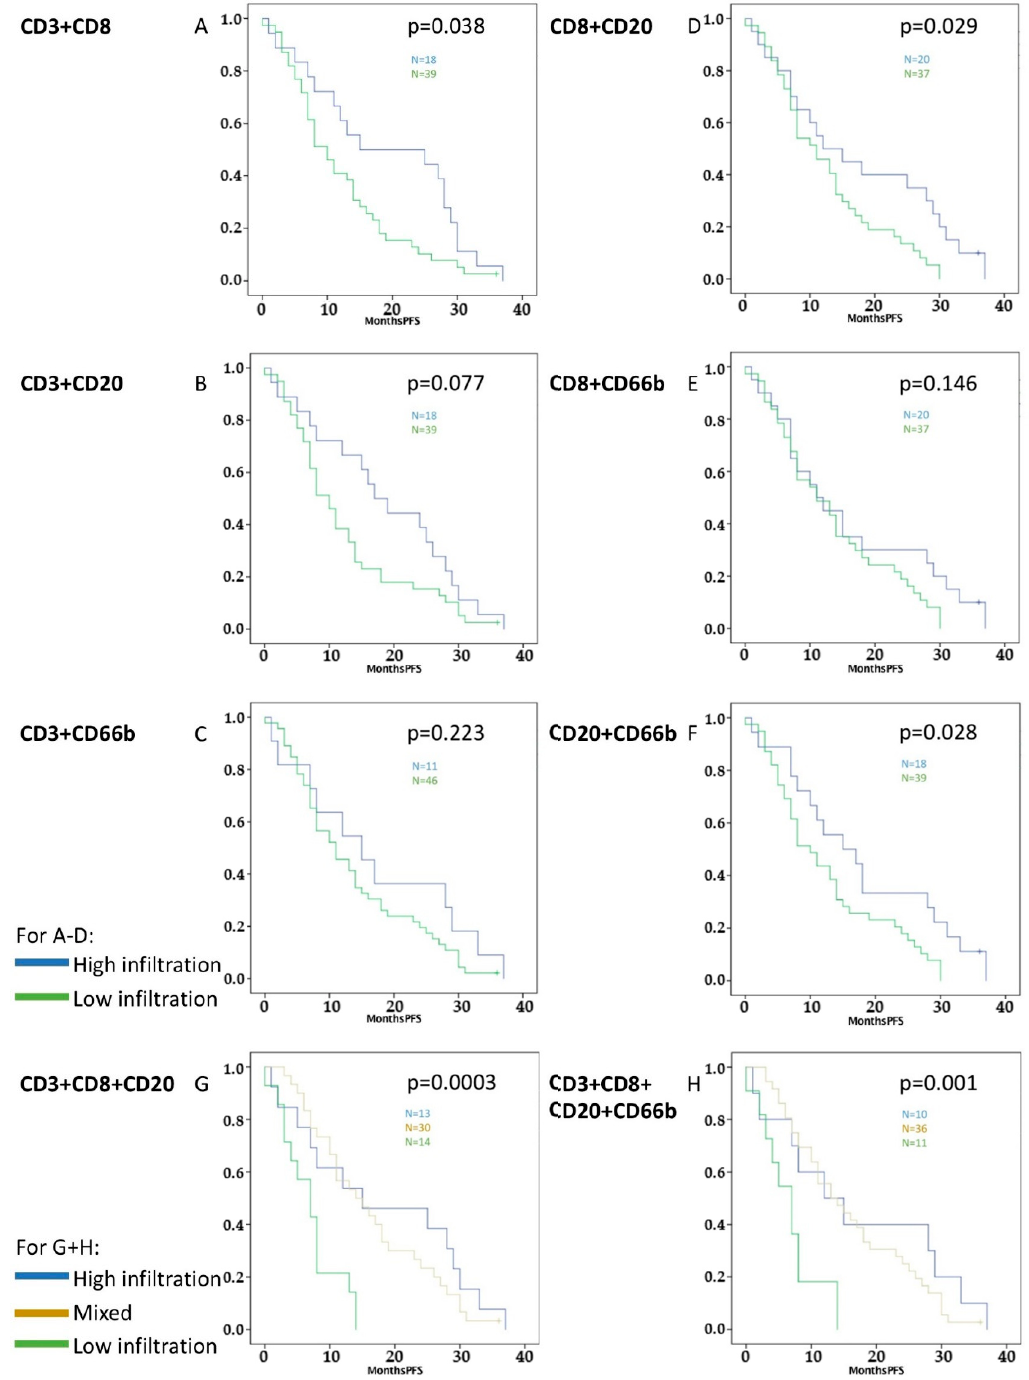
Figure 3. Survival graphs of PFS in relation to different combinations of TILs and TINs: Groups were formed by separating high infiltration in both cell types accordingly to Figure 2. ( A – F ) Groups were combined with two cell types, ( G ) with three, and ( H ) with four different cell types. High infiltration of CD3 + /CD8 + , CD3 + /CD8 + /CD20 + , CD8 + /CD20 + , CD20 + /CD66b + , and CD3 + /CD8 + /CD20 + /CD20 + /CD66b + tumor-infiltrating leukocytes correlated significantly with better PFS.